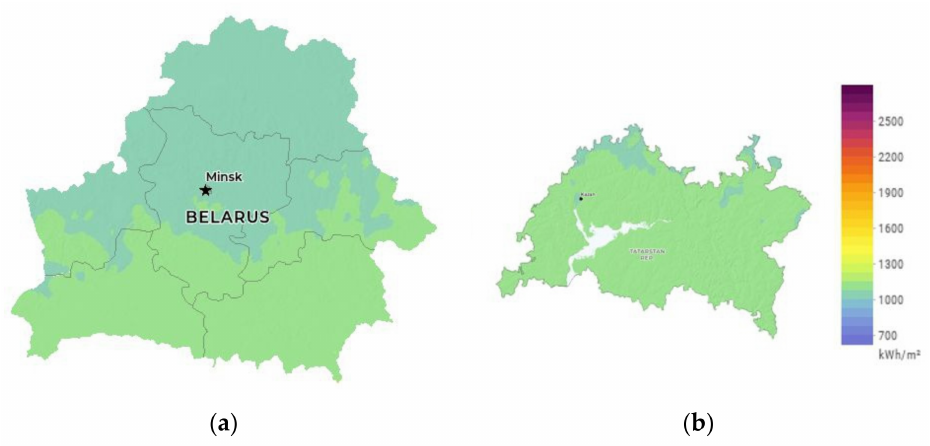
Figure 1. Average global horizontal irradiation in Belarus ( a ) and Tatarstan ( b ) [16]. Table 1. Comparative characteristics of Belarus and Tatarstan.